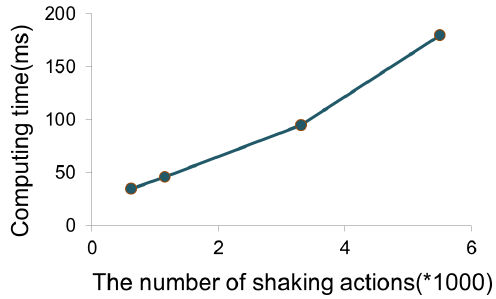
Figure 12. The relationship between the circumference of the erasure shape and the total data preprocessing